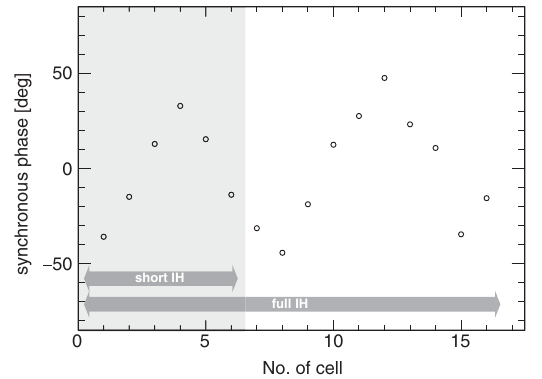
FIG. 1. Optimized phase array as a function of the cell number [16]. The short IH corresponds to the first six cells of the full IH.